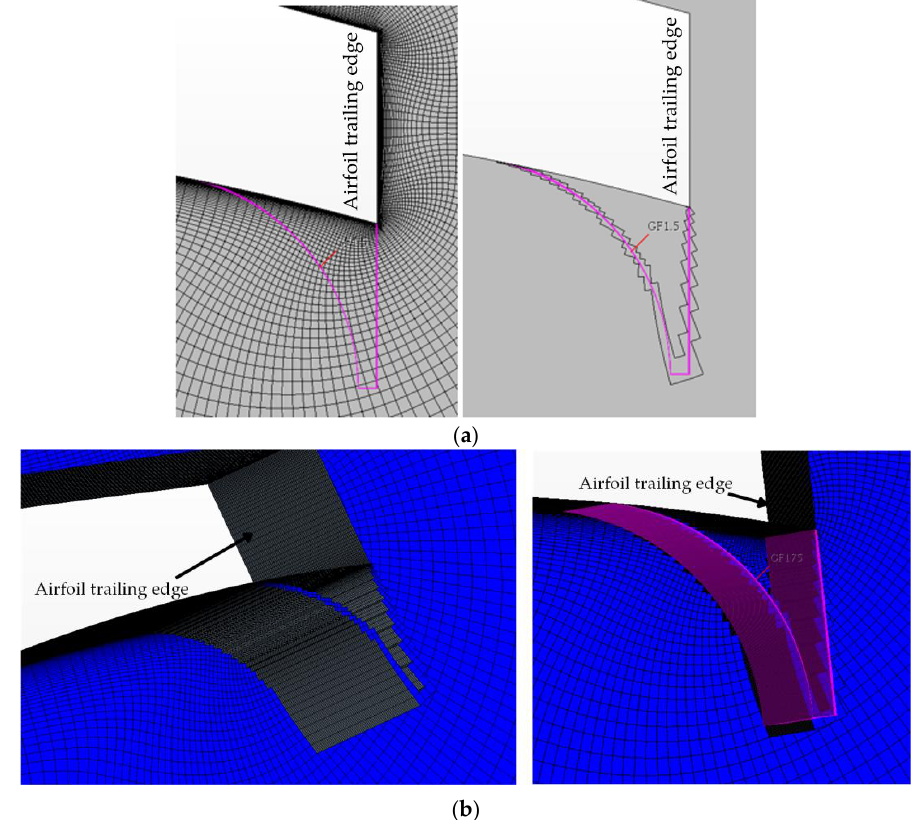
Figure 1. Cell-set construction based on the geometry of a GF: ( a ) two-dimensional case of a DU91W250 airfoil, equipped with a Gurney flap (GF) cell-set; ( b ) three-dimensional case of a DU97W300 airfoil, equipped with a GF cell-set (see Figure 3 for an entire airfoil context).